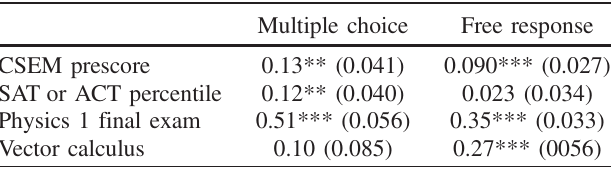
TABLE IV. Mixed-effects regression models predicting multi- ple-choice and free response scores on the physics 2 final exam. Numbers in parentheses are the standard errors of the coefficients. All coefficients are in units of standard deviations. *** p < 0 . 001 , ** p < 0 . 01 , * p < 0 . 05 .